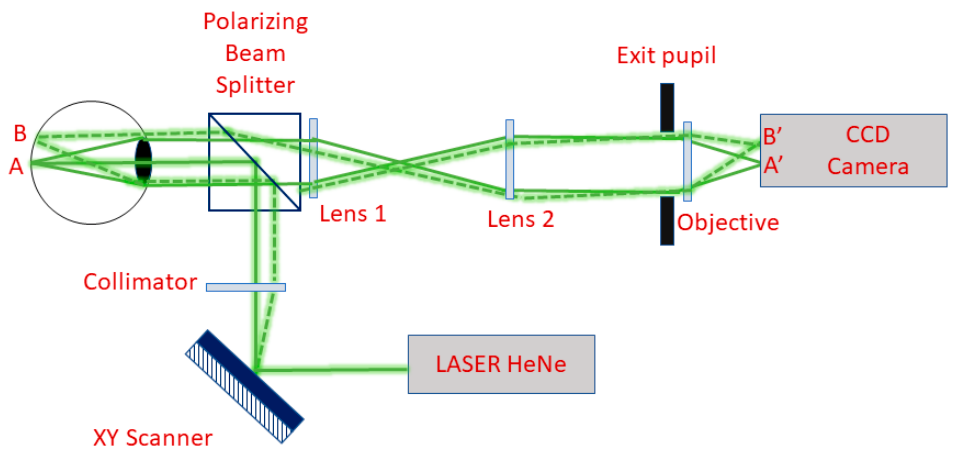
Figure 12. Basic setup of the laser ray tracing technique. The retinal image (A, B) is projected onto a CCD camera forming the image (A’, B’). Figure adapted with permission from Ref. [48] © The Optical Society.